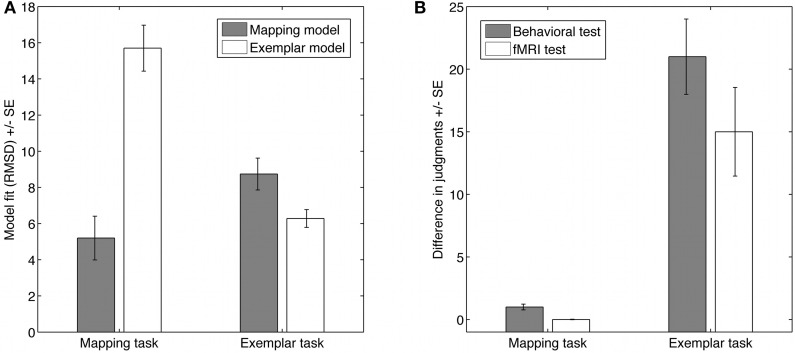
Behavioral evidence for the two strategies in the two tasks. (A) Shows the model fits for participants' judgments of the new items in the two tasks. (B) Shows the differences in judgments for item pairs with always three positive cue values each, but different cue values on each cue dimension. The results for the behavioral and the imaging study show that, as predicted by the mapping model, participants made similar judgments for these item pairs in the mapping task, but as predicted by the exemplar strategy made different judgments in the exemplar task (error bars = 1 SE).